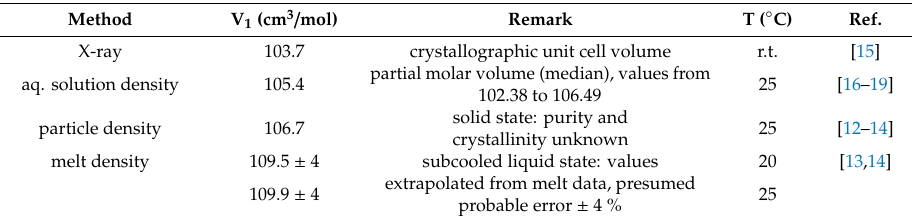
Table 1. Estimates for the molar volume V 1 of l -ascorbic